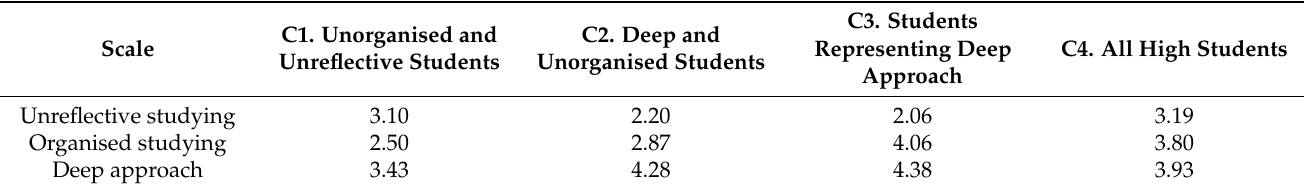
Table 2. Cluster centres.